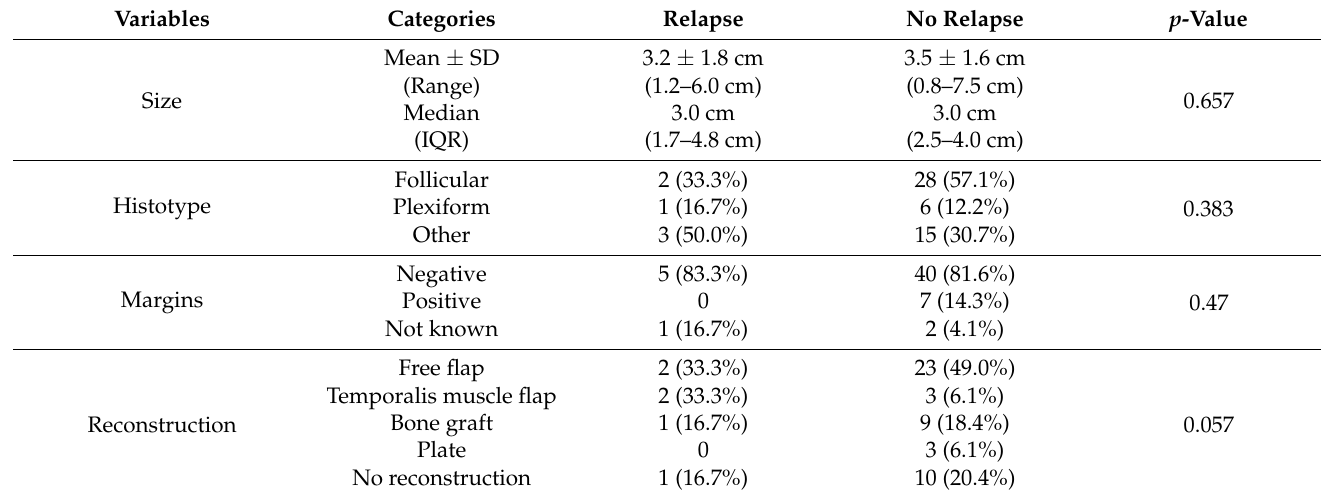
In Figure 1, disease-free survival is displayed with a Kaplan–Meier plot. Furthermore, by stratifying the sample by age—using 40 years as the cut-off age—and site, it is possible to plot the Kaplan–Meier curves (Figures 2 and 3). possible to plot the Kaplan–Meier curves (Figures 2 and 3).